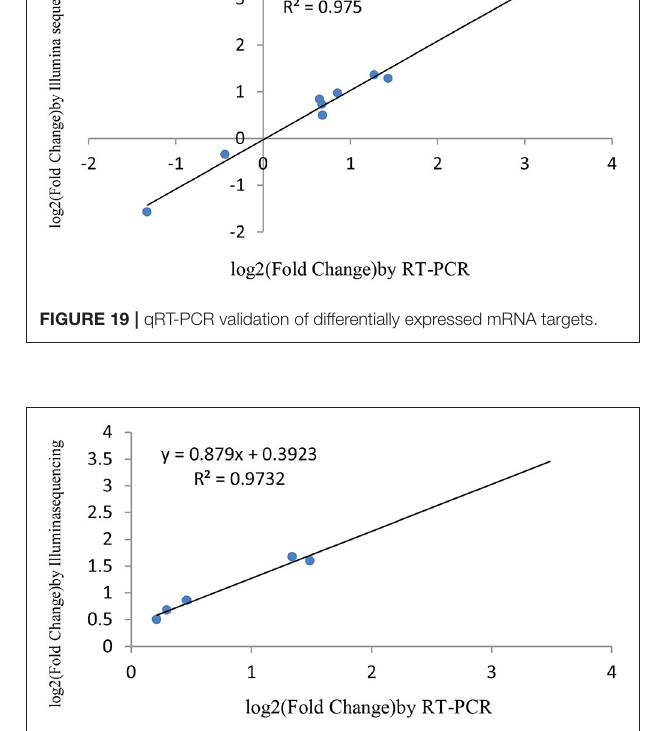
FIGURE 20 | qRT-PCR validation of the five